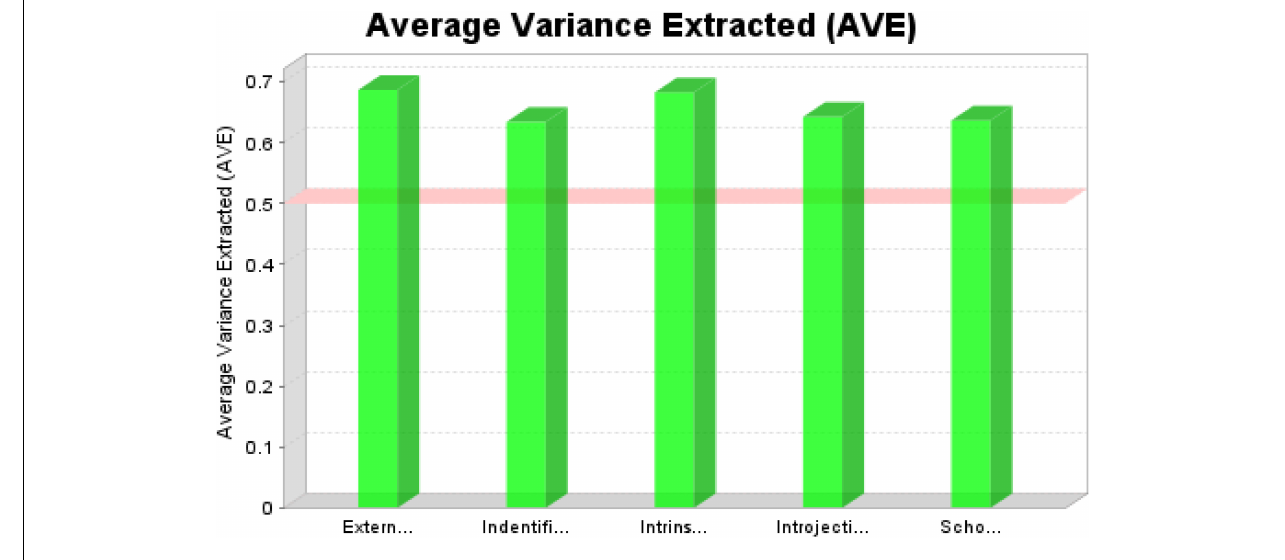
FIGURE 2 | Average variance extracted (AVE).